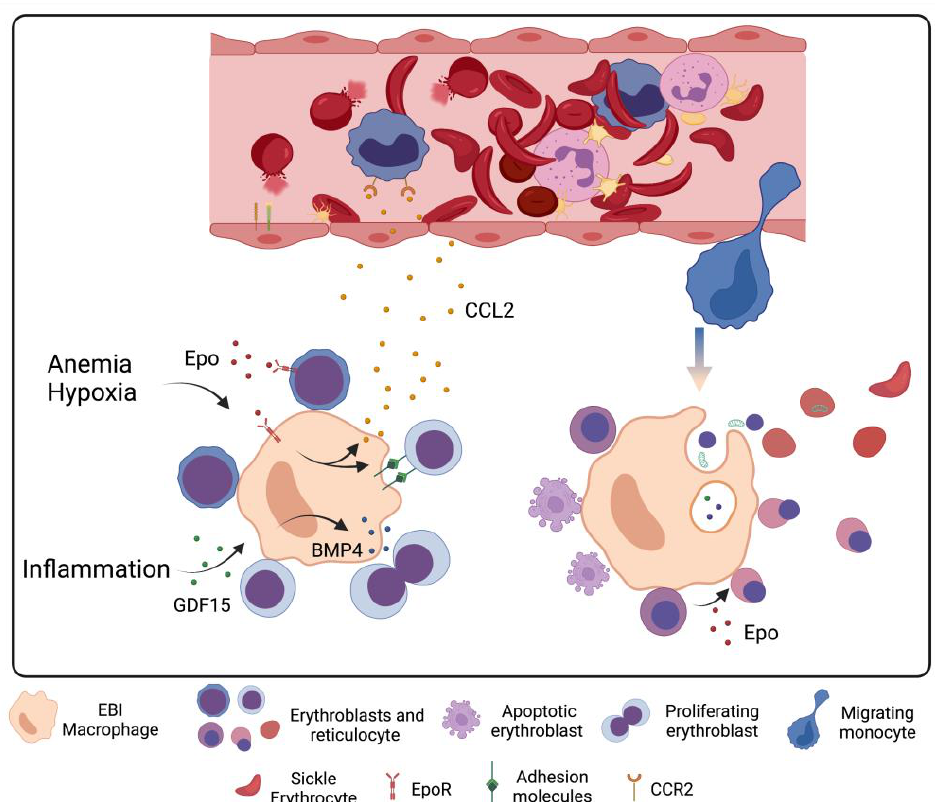
Figure 2. Role of macrophages in stress erythropoiesis in sickle cell disease. Upon homeostasis, macrophages located in the EBI of the bone marrow provide support for erythroblast proliferation and development through production of soluble factors and adhesion molecules, iron provision and engulfment of the extruded nucleus and organelles. Under conditions of anemia and hypoxia, macrophages sense the increased level of erythropoietin (Epo) through the EpoR, which elevates the set of adhesion molecules responsible for the attachment to different development stages of erythroblasts. The Epo–EpoR interaction also up-regulates the production of CCL2, which attracts circulating CCR2-expressing monocytes to bone marrow and to extramedullary sites, especially spleen and liver, where they differentiate in EBI macrophages, increasing erythropoiesis. Inflammation, on the other hand, stimulates erythropoiesis by a distinct stress-specific mechanism. Inflammatory cytokines induce the production of BMP4 by EBI macrophages through the elevation of GDF15. BMP4 stimulates the proliferation of erythroblasts attached to macrophages, increasing stress erythropoiesis. The production of HbS by late erythroblasts in SCD is implicated in their sickling, which causes an excessive rate of cell death between the polychromatic and orthochromatic stages of differentiation, resulting in an ineffective erythropoiesis. Created with Biorender.